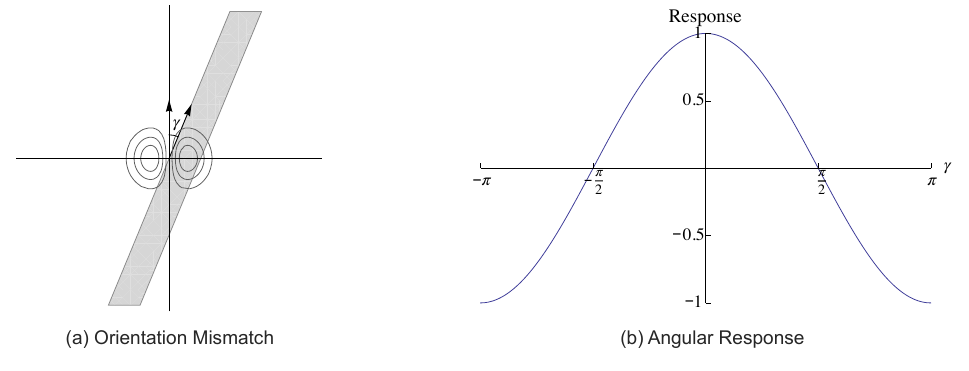
Figure 3. Angular response of FDOG.